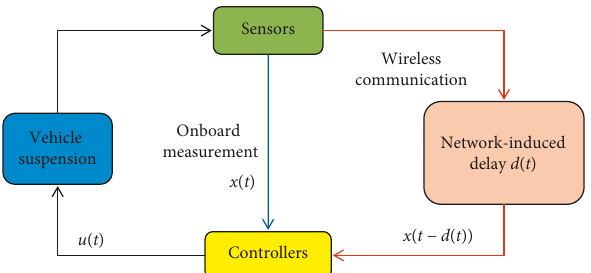
Figure 2: Miscellaneous information feedback control